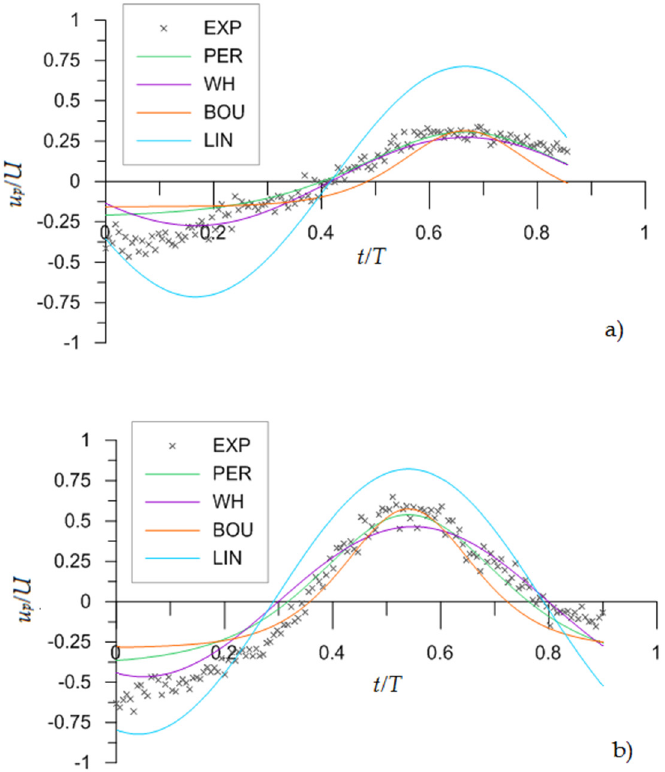
Figure 3. Comparison of computed u and experimental phase-averaged streamwise velocity u p at point X = 10.95 m, Y = 0.07 m, and Z = 0.035 m for W1 ( a ) and W2 ( b ).